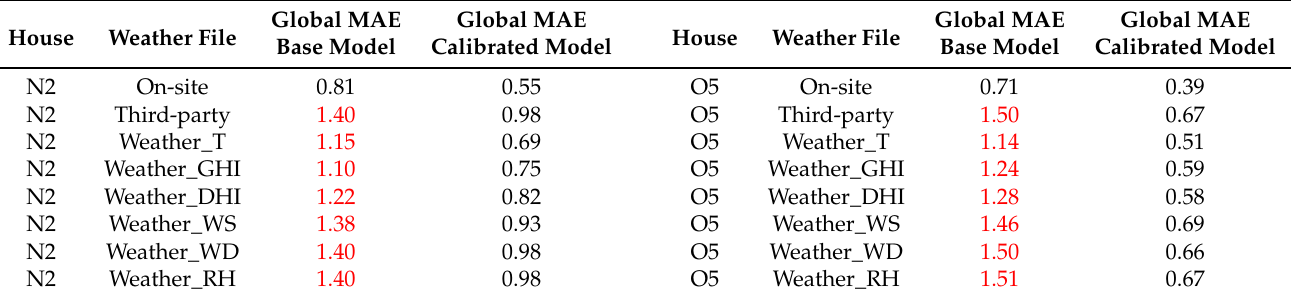
Table 3. Comparison of results between the base and calibrated models in the training period. The N2 and O5 houses.